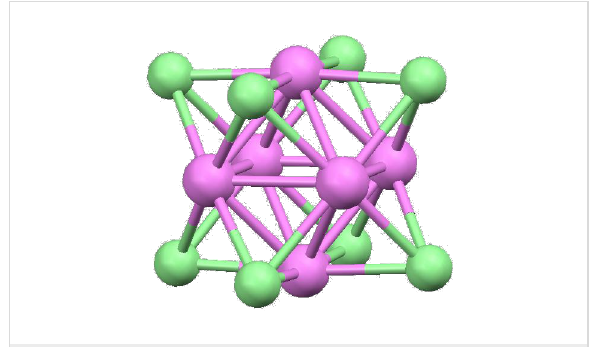
Figure 2: The structure of [Mo 6 Cl 8 ] 4+ demonstrates the reciprocal rela- tionship between the cube and the octahedron.